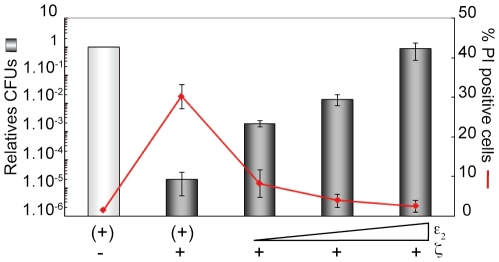
Variations of free ζ toxin levels differentially affect dormancy and permeation to PI.
lacI-P
hspζ (xylR-P
XylAε) cells were grown in MMS7 at 37°C up to ∼5×107 cells ml−1 in the presence of traces of Xyl (0.005%, denoted as (+), to allow limiting ε2 antitoxin expression to titrate basal expression of the wt ζ toxin. IPTG (1 mM) and variable amounts of Xyl (0.05, 0.1 and 0.5%) were added and the culture incubated for 120 min. Aliquots were taken and appropriate dilutions were plated in Luria-Bertani (LB) plates with the same concentration of Xyl, or analyzed under the microscope after live-dead staining. Means of four parallel experiments ±95% confidence intervals are shown.